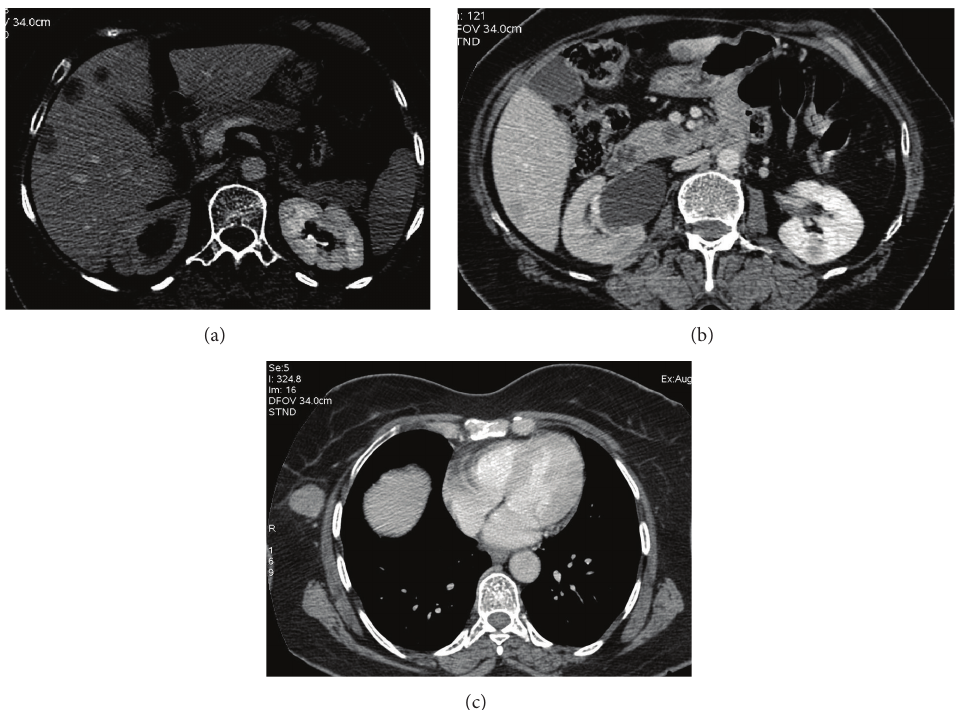
Figure 2: Prechemotherapy CT scan showing multiple ill-defined hypodense lesions in liver (a) and hypodense lesion in the uncinate process of pancreas (b) and in the right chest wall (c). Moderate hydronephrosis on right side secondary to lower ureteric involvement by the cervical mass